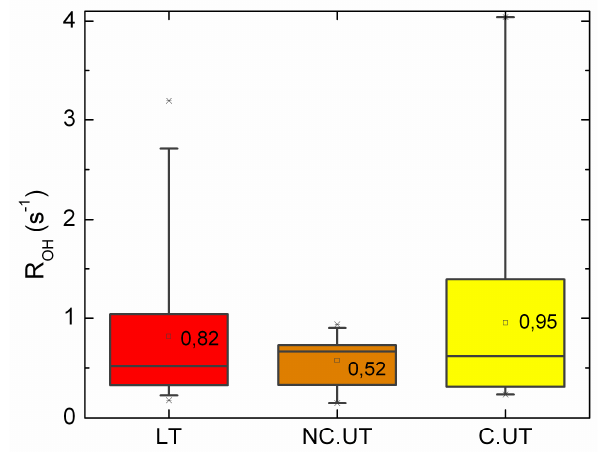
Supprimé : Vertical lines are error bars, mean fraction is in red, transparent grey area is standard deviation and dashed lines are minimum and maximum literature data comparison.¶